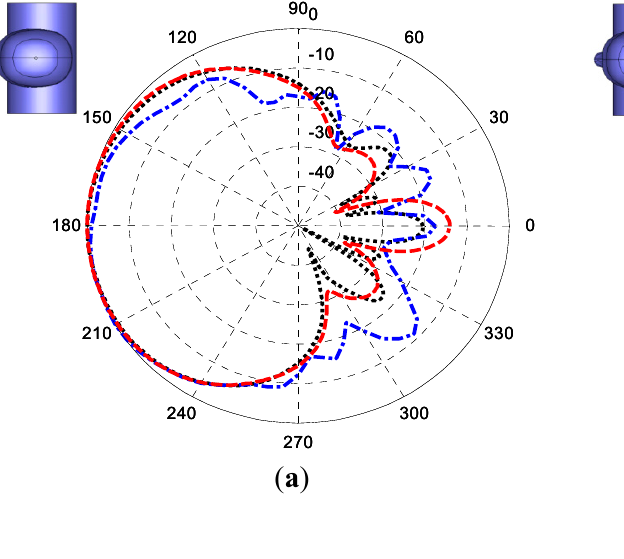
Figure 8. The H-plane cut radiation pattern of the AUT measured at 2.45 GHz: ( a ) co-polar field component; and ( b ) cross-polar field